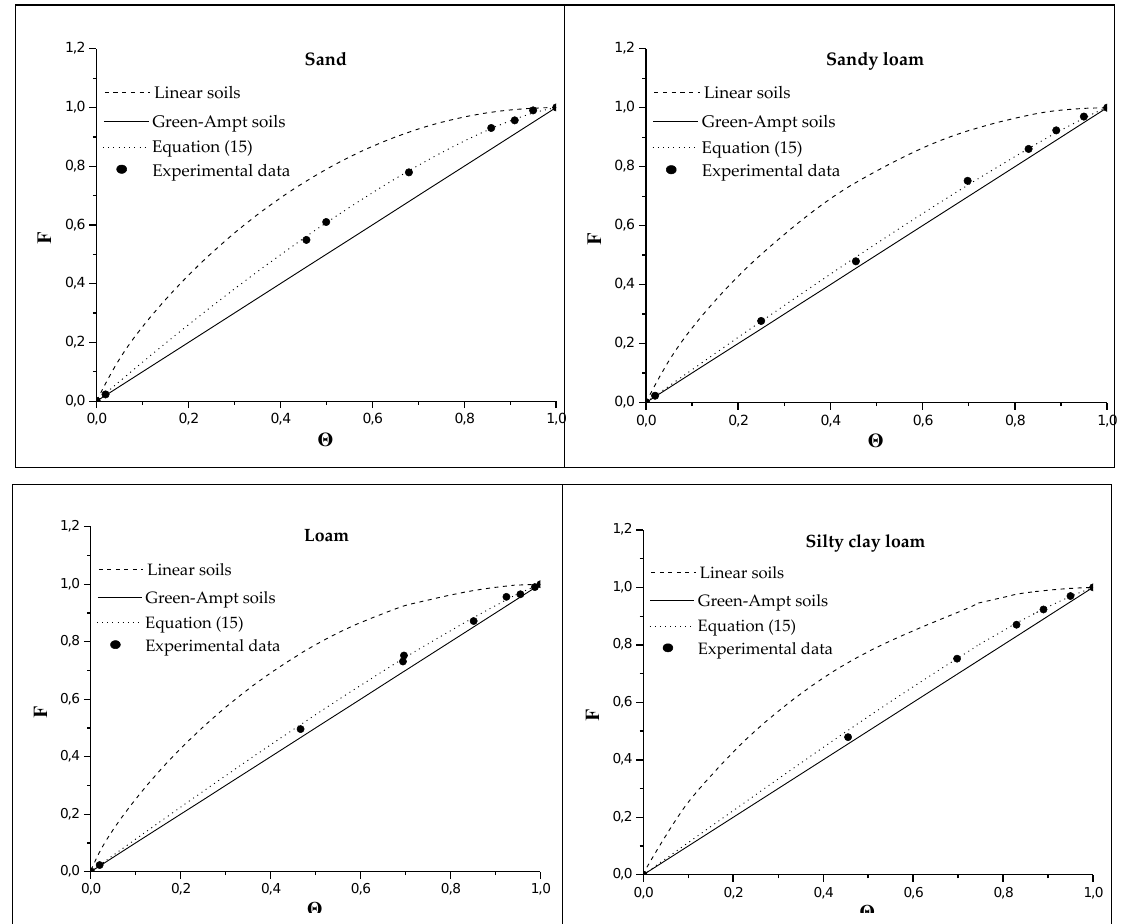
Figure 4. Comparative presentation of the relationship F (Θ) for the linear soils and Green–Ampt soils, as well as the F (Θ) calculated according to Equation (15) and the experimental F (Θ) values described in the text for the four soils examined.